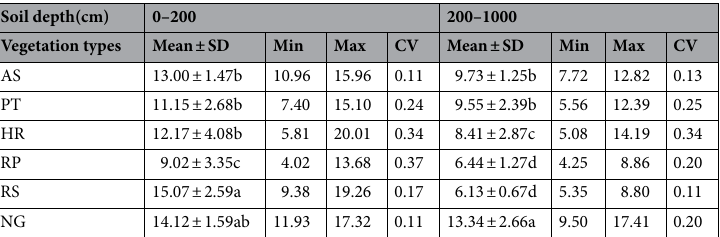
Table 3. Variance analysis and multiple comparisons of average soil moisture (%) in different soil layers of different types of vegetation (0–200 cm and 200–1000 cm). One-way analysis (α = 0.05, LSD). All numbers followed by the same letters in the same column are not significantly different, while those marked with different letters are significantly different.